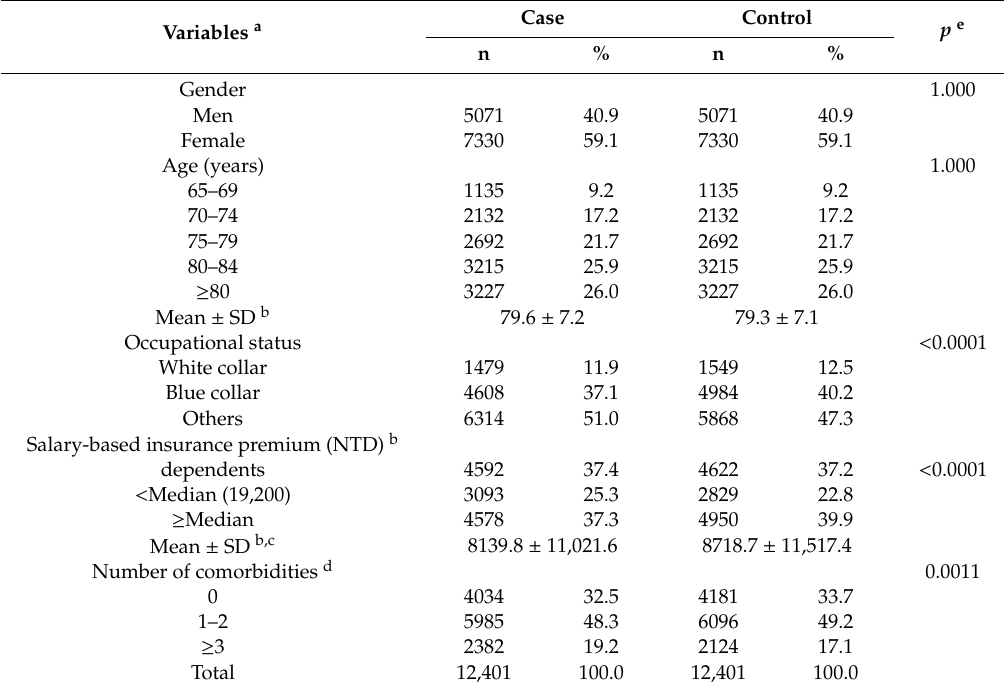
Table 1. Characteristics of participants according to Alzheimer’s